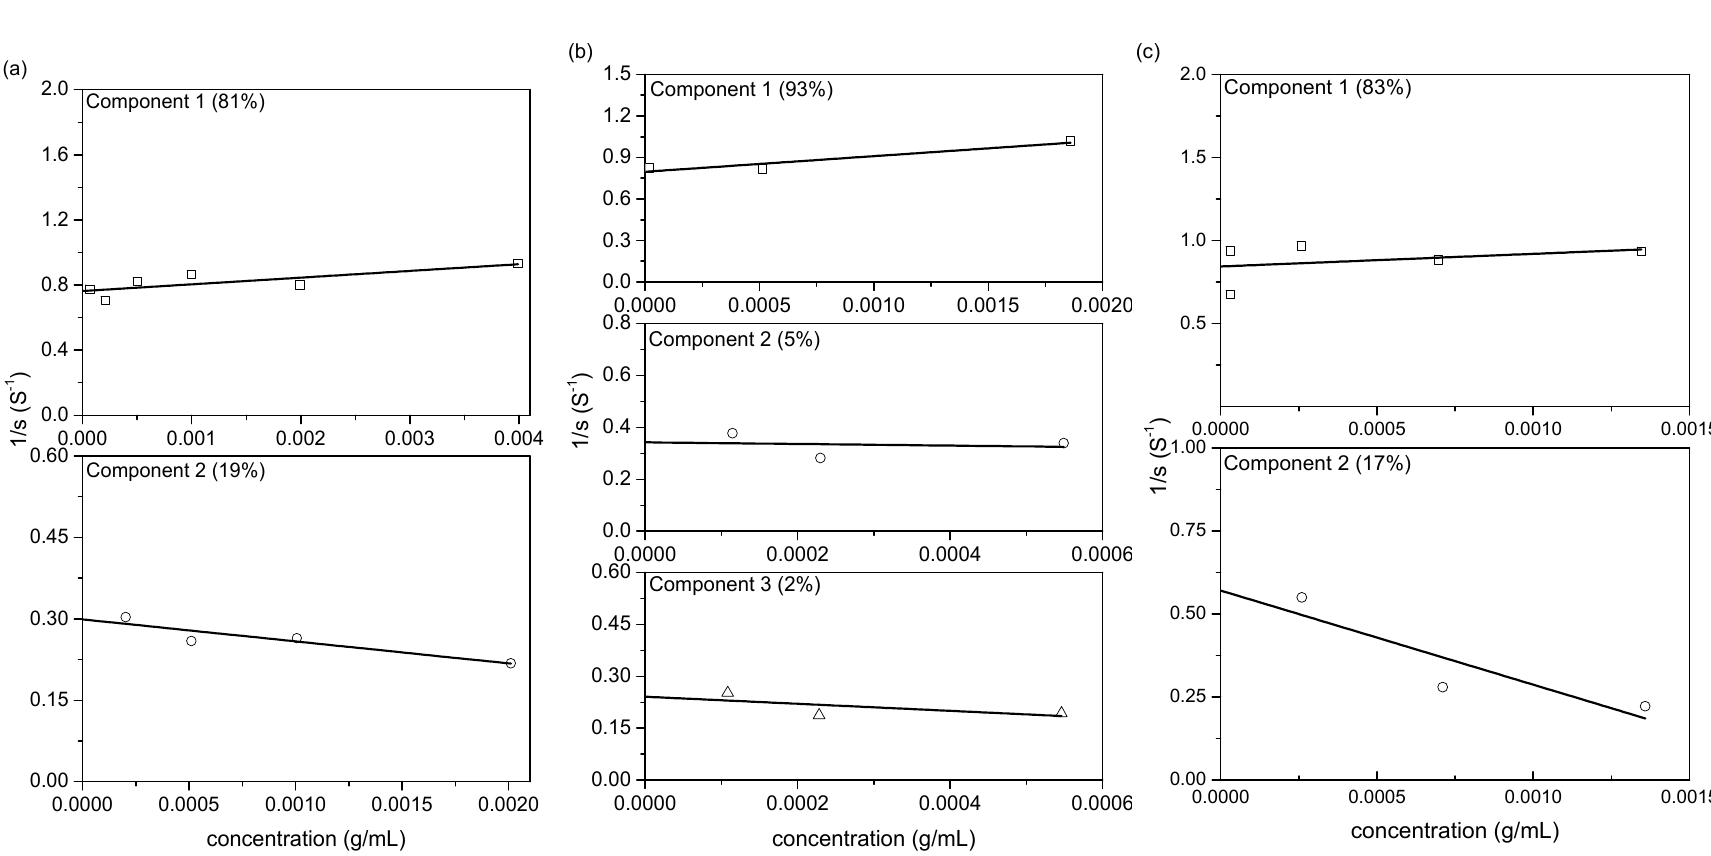
Figure 3. Concentration dependence of the reciprocal sedimentation coefficient ( a ) NJBTF1, ( b ) NJBTF2, ( c ) NJBTF3.